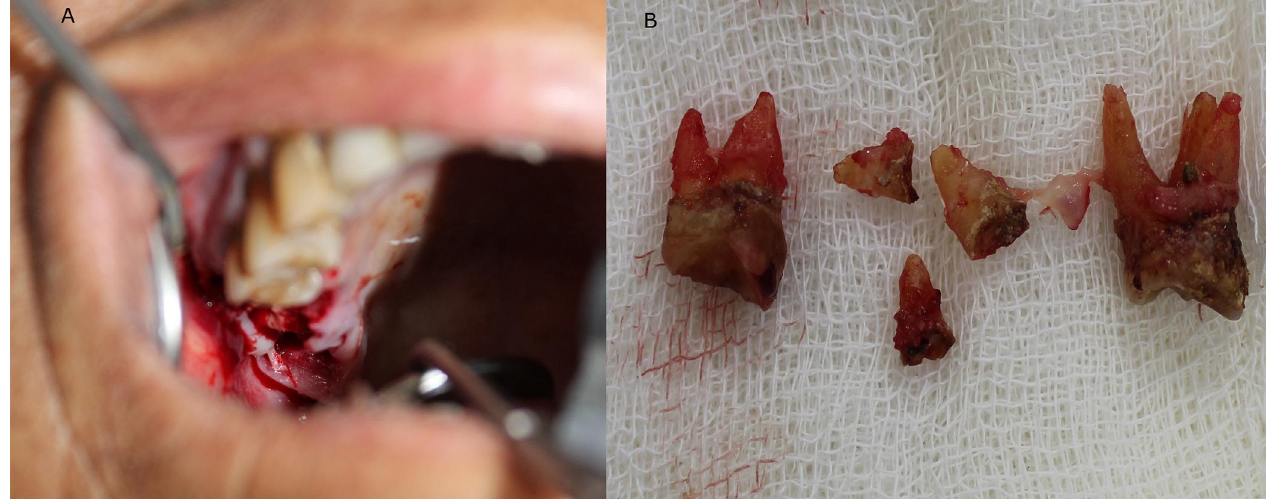
Fig. 4. Drainage established intra-orally through buccal vestibule (A), Extraction of carious teeth from posterior maxilla